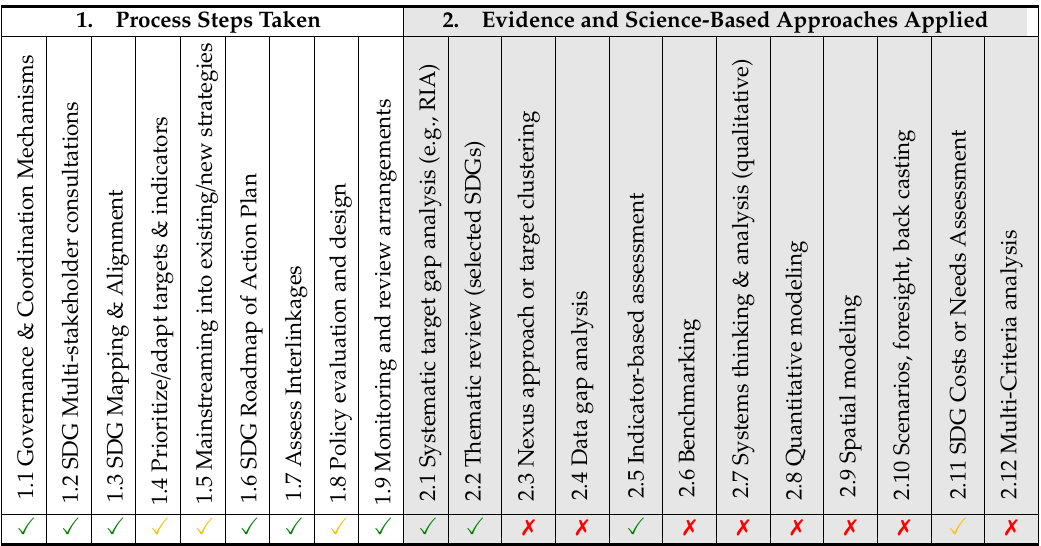
Table A2. Overview of national implementation of the SDGs in Mexico—Process, Approaches and